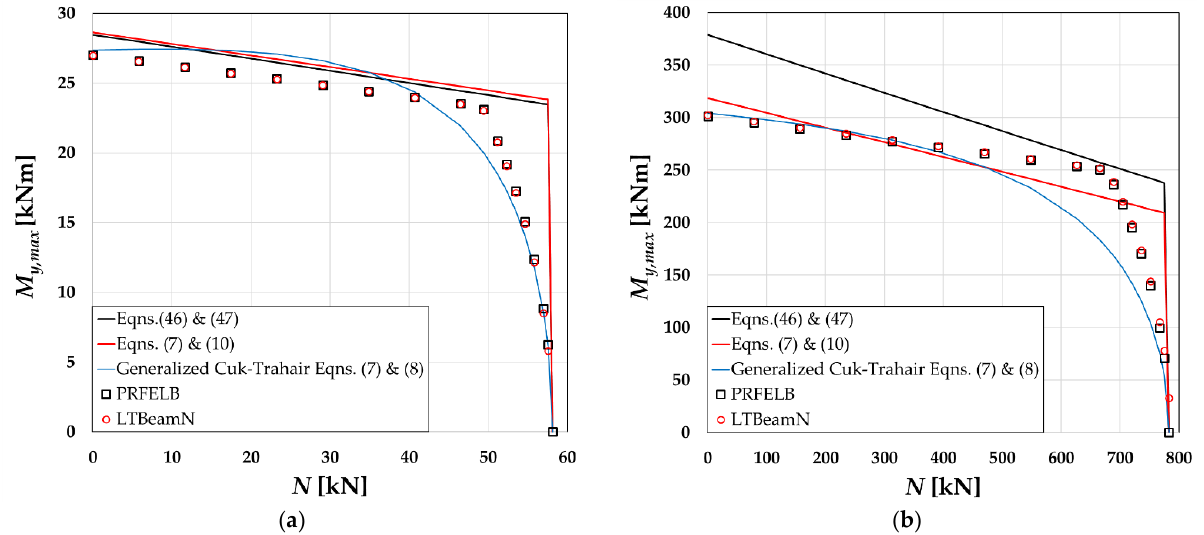
Figure 7. Verification of results from the present study with those from computer programs LTBeamN and PRFELB for Case 4 of the in-plane loading system: ( a ) beam-column of section IPE 180; ( b ) beam-column of section HEB 180.